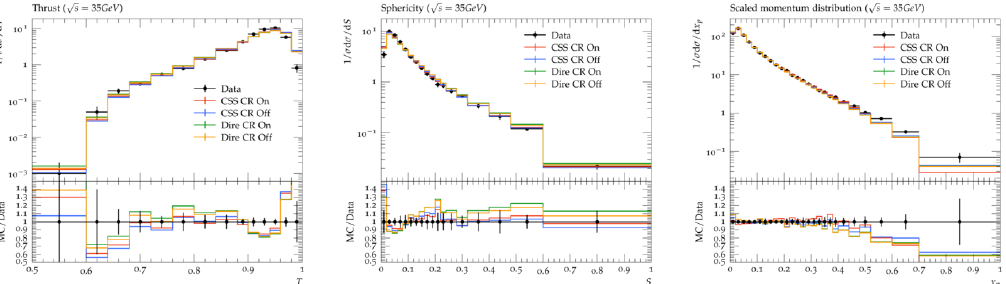
Figure 15: Various event shapes – from left: thrust, sphericity, and x all measured by T ASSO [ 73 ]